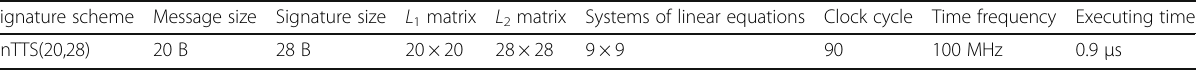
Table 2 FPGA implementation of hardware architecture for multivariate signature generation